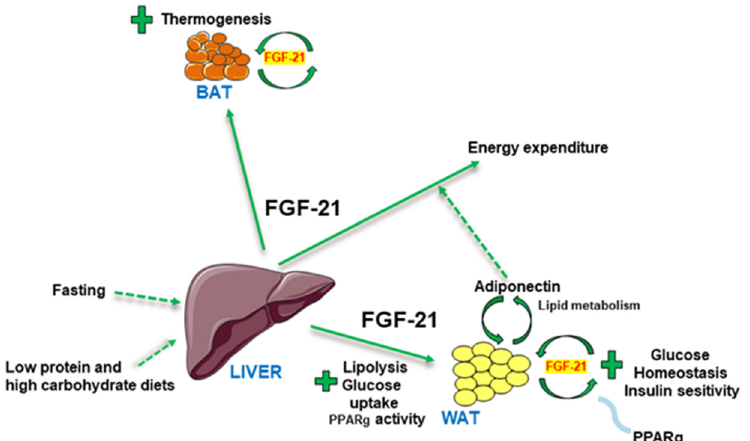
Figure 1. Description of the peripheral actions elicited by FGF21. FGF21 is a hepatic signal that improves several metabolic parameters such as energy expenditure, BAT thermogenesis, lipolysis, and glucose homeostasis. Abbreviations used: BAT: brown adipose tissue; FGF21: fibroblast growth factor-21; PPARg: Peroxisome proliferator-activated receptor gamma; WAT: white adipose tissue.